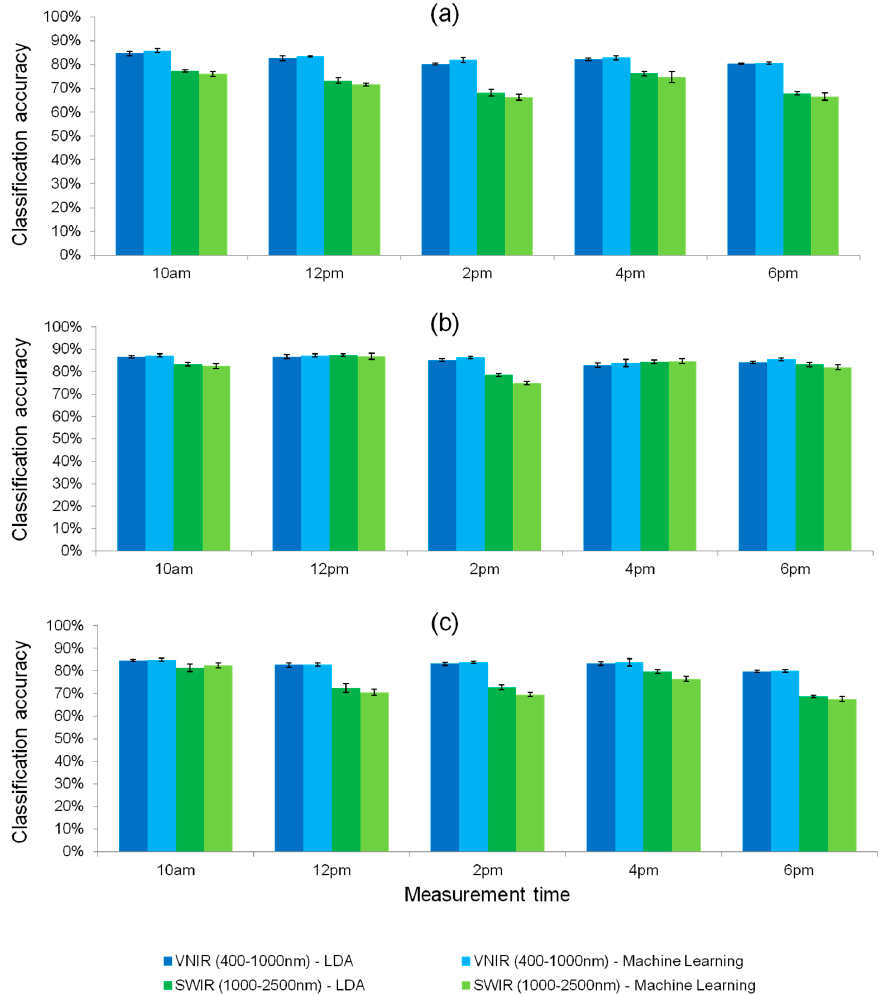
Figure 9. Classification accuracy for differentiation of sprayed vs. non-sprayed leaves measured from ( a ) west and east; ( b ) only west and ( c ) only east side. Across the results, the spectral reflectance data of the VIS-NIR range seems to be the more robust predictor for the spray status. Machine Learning and LDA approach are compared.